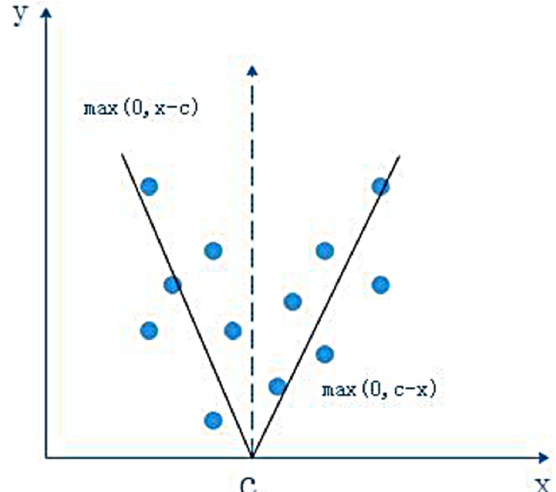
Figure 3. The hinge functions and knot location in the multivariate adaptive regression spline (MARS) model. (MARS)